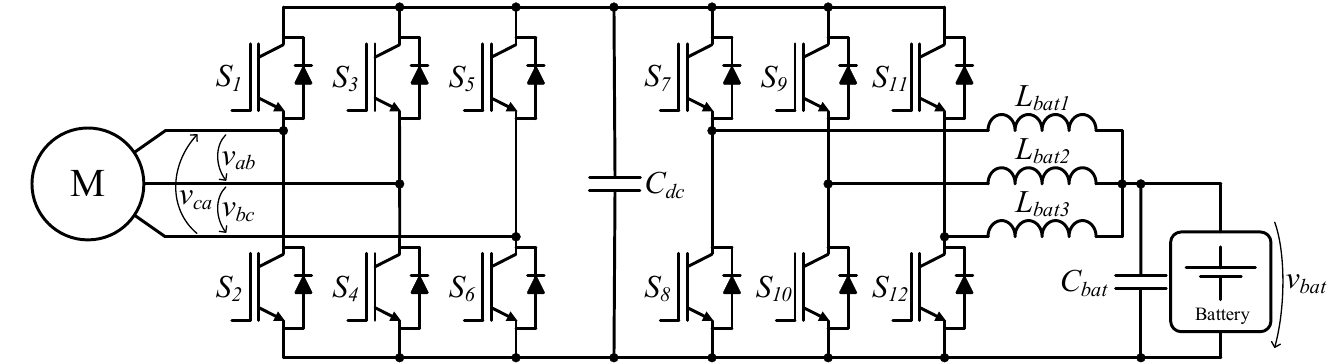
Figure 2. Schematic illustration of the traction system.